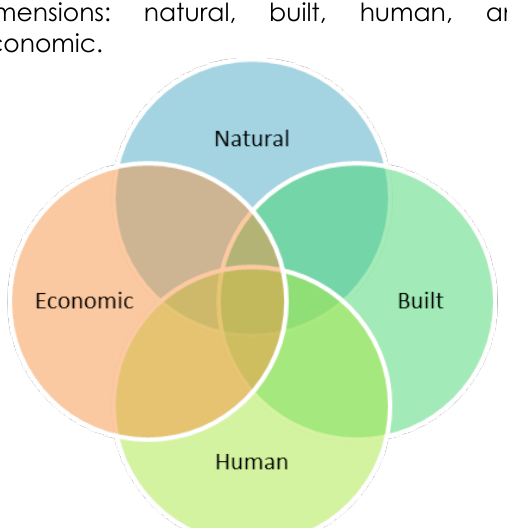
Figure 9 . The Sustainable Tourism Development Model.